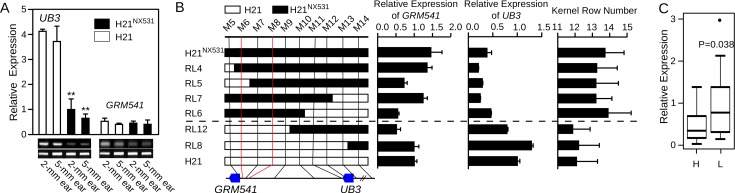
Analysis of UB3 and GRMZM2G001541 expression.A) Expression patterns of UB3 and GRMZM2G001541 (GRM541) in immature ears of H21 and H21NX531, **: P-value < 0.01. B) Analysis of UB3 and GRMZM2G001541 (GRM541) expression in recombinant lines in immature 2-mm ear. The white boxes in the graphical genotype represent the genomic segment from H21, and the black boxes represent the genomic segment from H21NX531. C) Expression of UB3 in immature 2-mm ear in 38 diverse inbred lines. H represents lines with the H21NX531genotype at the KRN4 locus (N = 12), and L represents lines with the H21genotype at the KRN4 locus (N = 26).